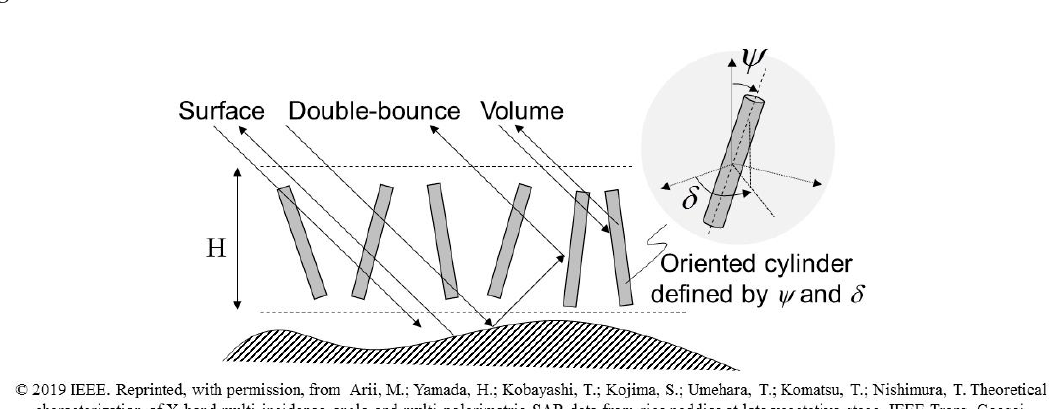
Figure 10. Various scattering mechanisms, volume, double-bounce and surface scatterings, from a cloud of oriented cylinders on the ground. An orientation of each cylinder is defined by ψ (elevation) and δ (azimuth) [32].